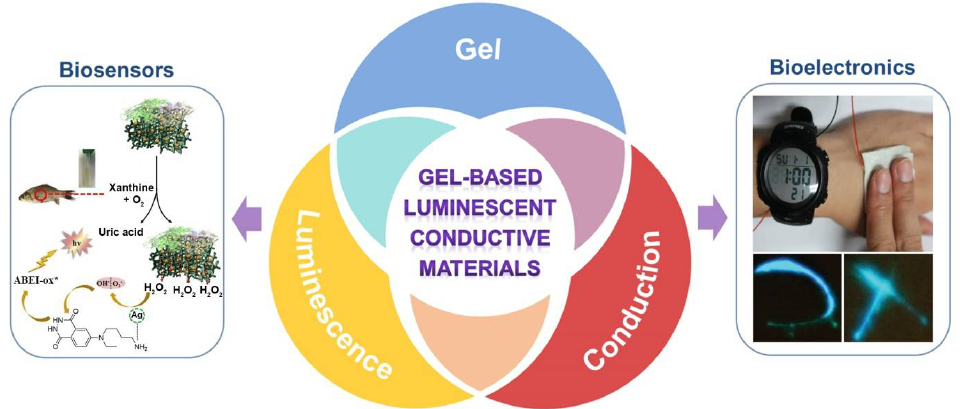
Figure 1. Summary of gel-based luminescent conductive materials and their applications in biosensors and bioelectronics. Figure of application example in biosensors was adapted with permission [26]; copyright 2019, Elsevier Ltd. Figure of application example in bioelectronics was adapted with permission [27]; copyright 2019, Wiley–VCH Verlag GmbH & Co. KGaA,